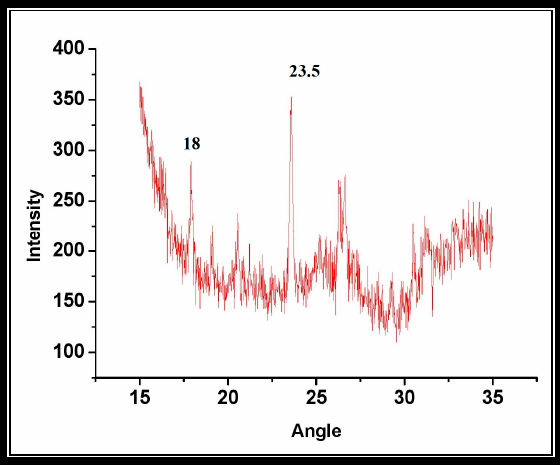
Figure 1. XRD pattern of polyaniline nanofibers.